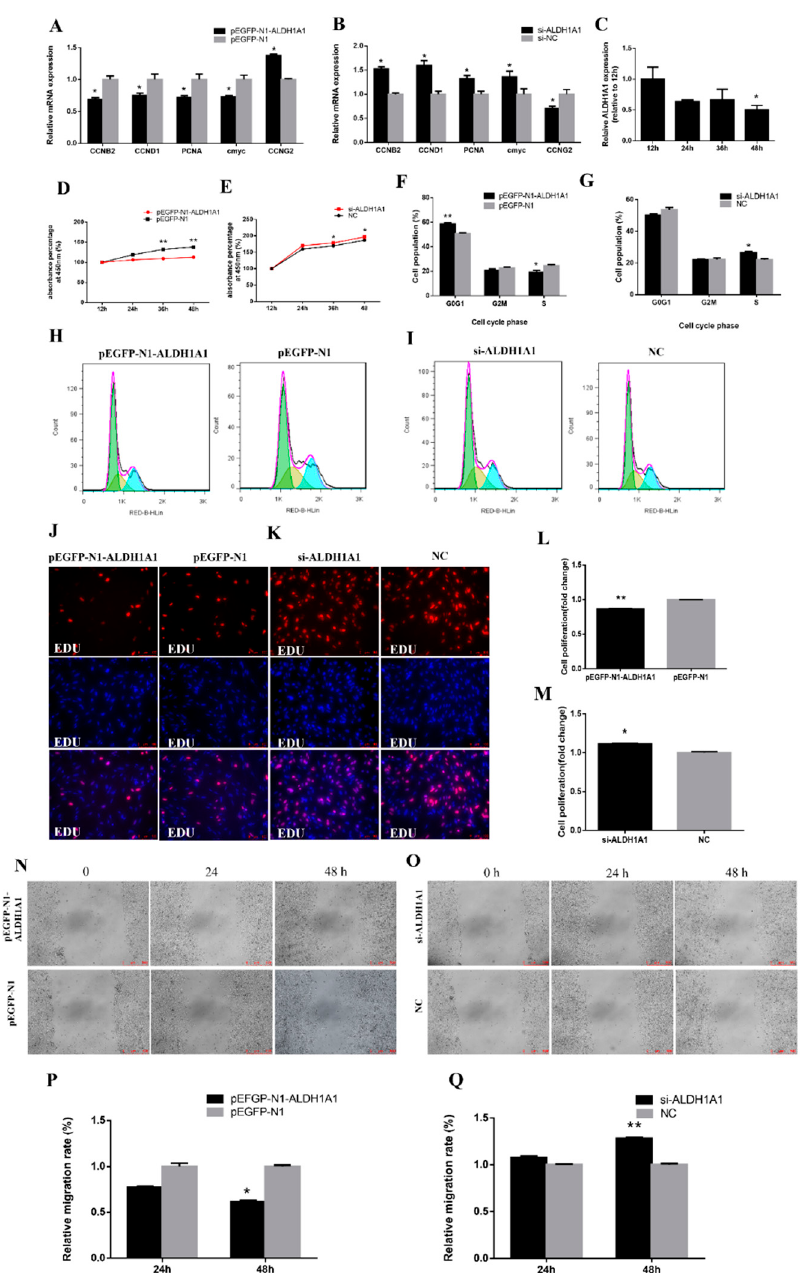
Figure 3. ALDH1A1 represses chicken preadipocytes’ proliferation. ( A,B ) The mRNA expression of the cell cycle related gene after transfection for 48 h in chicken primary preadipocytes ( n = 6). ( C ) The relative mRNA expression of ALDH1A1 during proliferation in immortalized chicken preadipocyte 1 (ICP1) was measured by real-time quantitative polymerase chain reaction (RT-qPCR) using Dunnett’s test ( n = 6, * p < 0.05; ** p < 0.01). ( D,E ) Cell growth relative to the “12 h” group was measured following the transfection of the overexpression vector of ALDH1A1 and siRNA of ALDH1A1 in ICP1 ( n = 6). ( F - I ) Cell cycle analysis of ICP1 48 h after overexpression and inhibition of ALDH1A1, using propidium iodide staining for DNA content ( n = 6). ( J,K ) Proliferation of transfected ICP1 was assessed by 5-ethynyl-2 ′ -deoxyuridine (EdU) incorporation, scale bar: 100 μ m. ( L,M ) Proliferation rates of ICP1 with ALDH1A1 overexpression and inhibition ( n = 6). ( N,O ) The scratch test detected the effect of ALDH1A1 on cell migration, scale bar: 500 μ m. ( P,Q ) Migration rate of ICP1 with ALDH1A1 overexpression and inhibition ( n = 6). In all panels, data are presented as the mean ± S.E.M. of three biological replicates. Statistical significance of differences between means was assessed using an unpaired Student’s t -test (* p < 0.05; ** p < 0.01) or Dunnett’s test (* p < 0.05; ** p < 0.01).